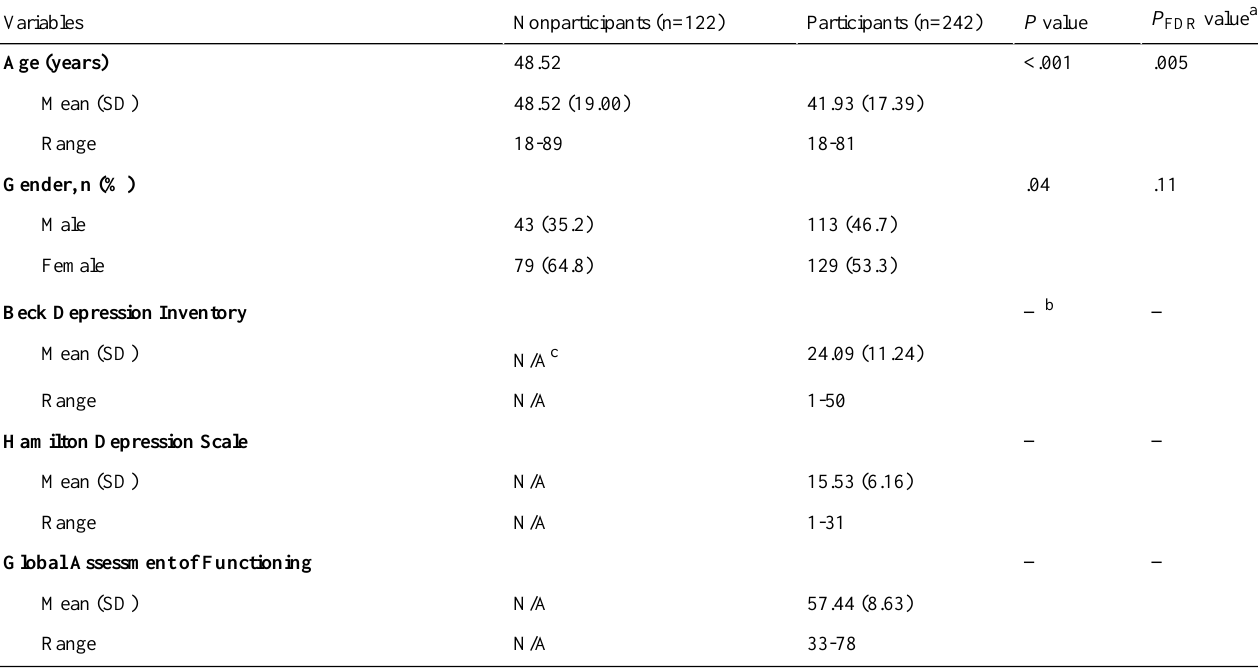
Table 3. Sociodemographic and clinical characteristics of patients who were initially approached for participation, consisting of 122 nonparticipating patients and 242 study